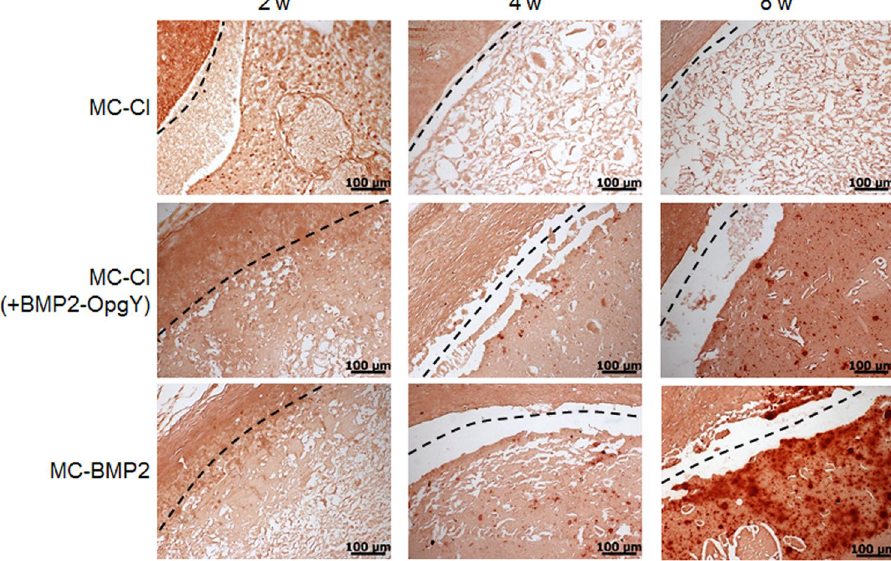
Figure 10. Alizarin Red S-stained histological sections of engineered bone from mice implanted with human periodontal ligament stem cells on MC-Cl, MC-Cl ( + BMP2-OpgY), or MC-BMP2 hydrogels removed after 2, 4, or 8 weeks (magnification 200 × , scale bars represent 100 μ